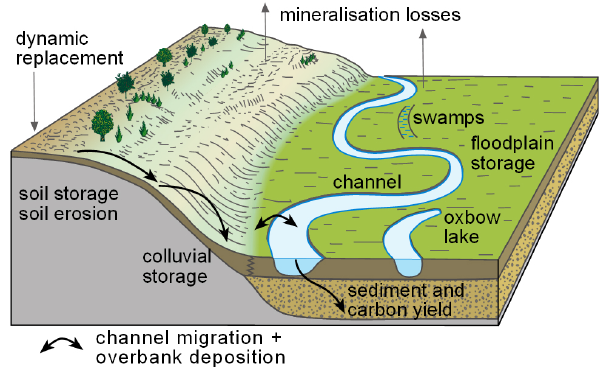
Figure 1. Storage compartments and lateral and vertical C-fluxes in agricultural